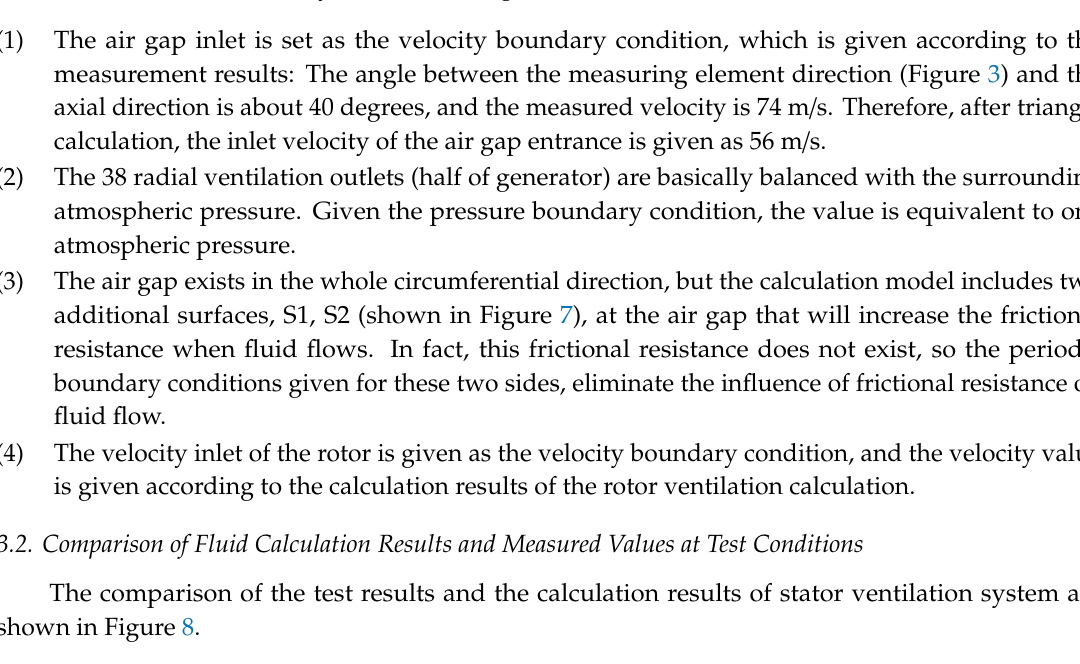
Figure 7. Model axial–radial and circumferential sections grid mesh.